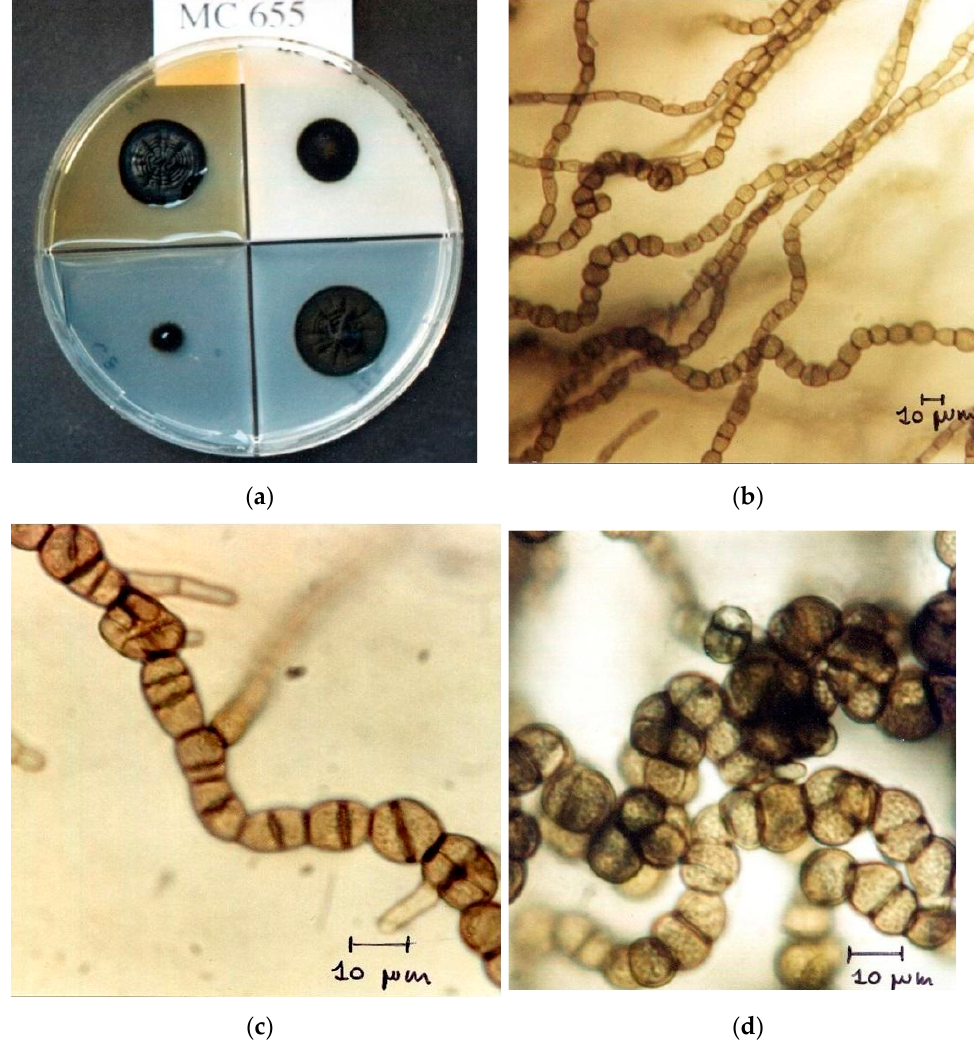
Figure 1. Main morphological characteristic traits of MicroColonial Fungi, MCF. Dark black colonies due to the melanin production as seen ( a ) for the unidentified strain MC 655 on different cultural media after 1 month of incubation. ( b – d ) characteristic meristematic pattern of growth described also as Torula -like hyphae observed under Light Microscope. Bar is 10 μ m .